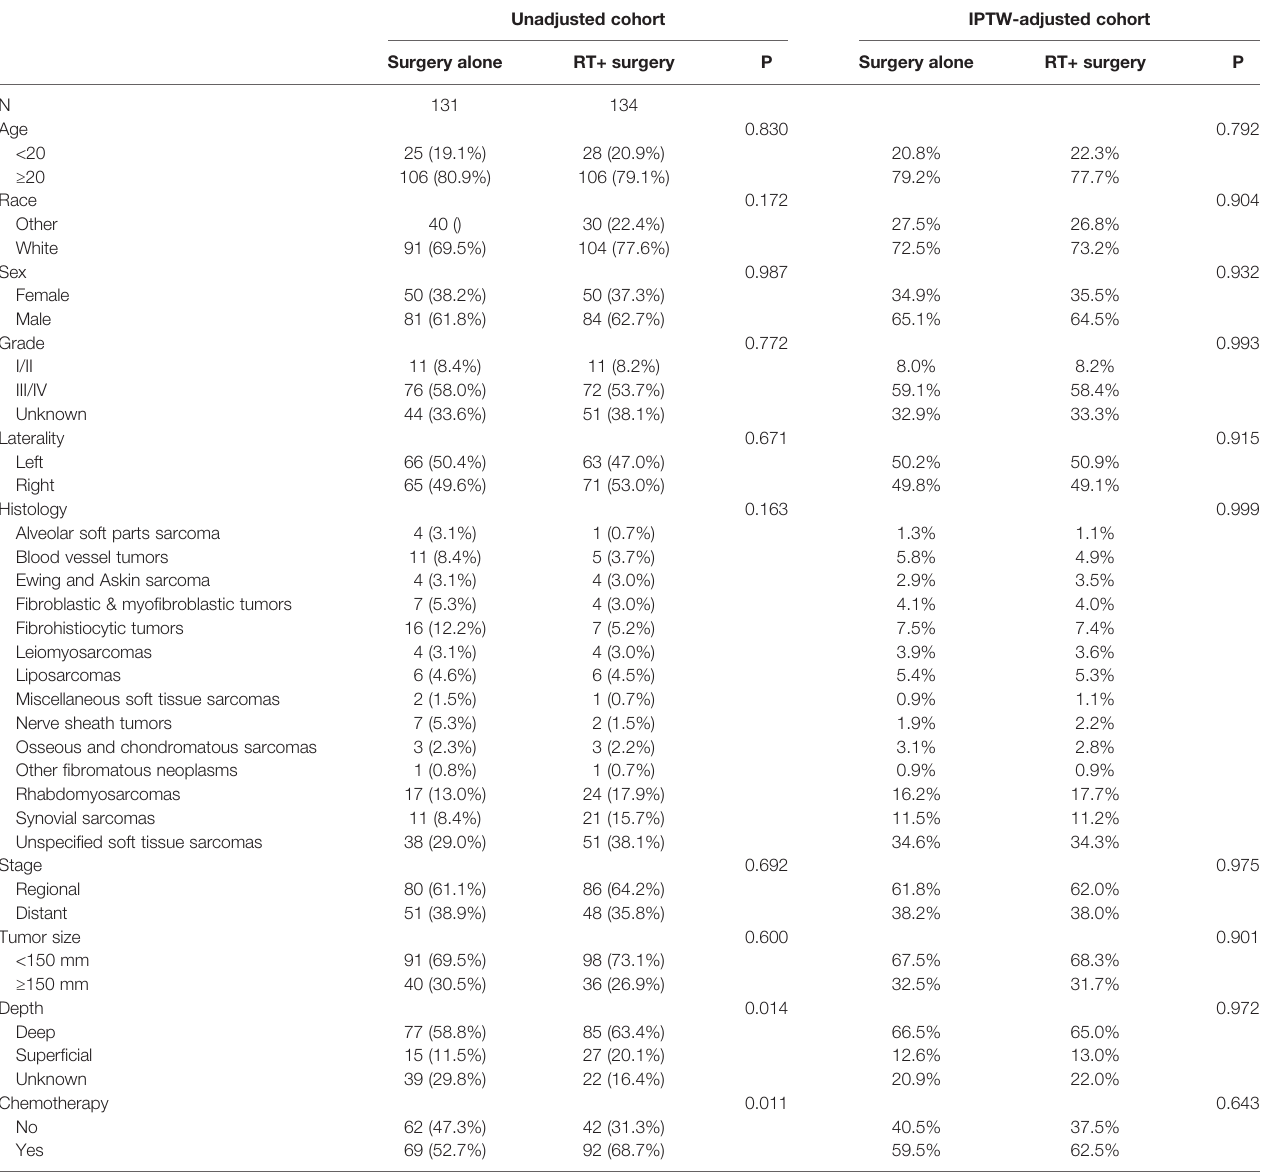
TABLE 1 | Sociodemographic and clinical characteristics of study